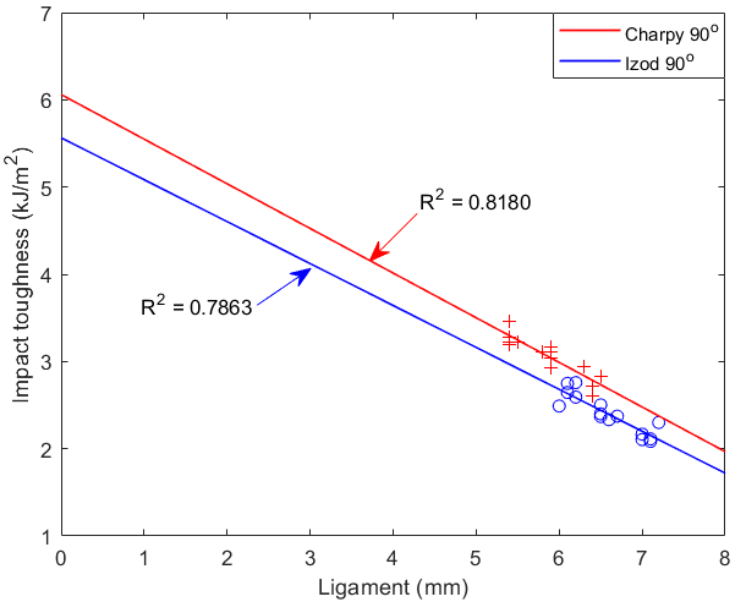
Figure 6. Dynamic toughness with various ligaments. ‘+’ represents Charpy toughness with notch angle of 90°; ‘o’ represents Izod toughness with notch angle of 90°. Results of numerical simulation with w 0 = 5.56 and 6.06 kJ/m 2 , respectively.